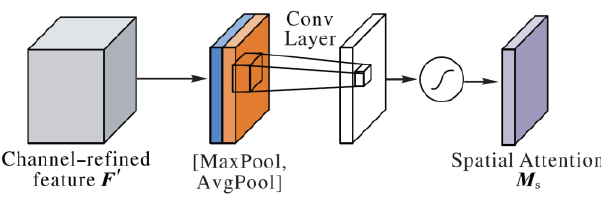
Figure 4. Spatial attention